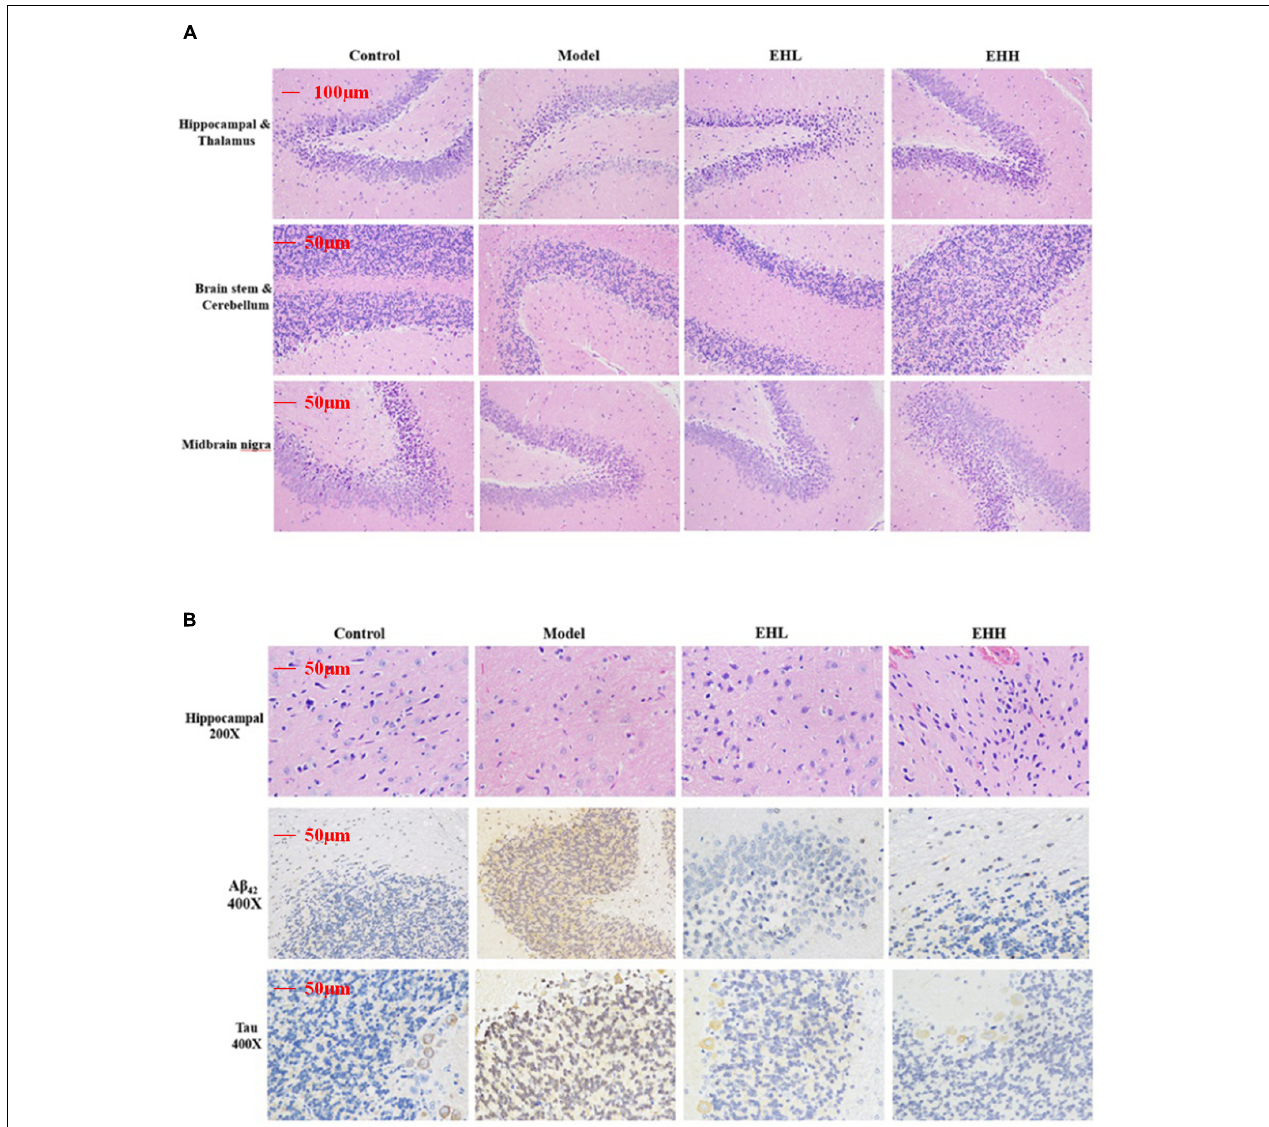
FIGURE 2 | Histopathological changes and immunohistochemistry staining of Tau and A β 42 in the brain tissues of D -galactose- induced deficit rats. (A) is the hematoxylin-eosin (HE) staining of hippocampal and thalamus, brain stem and cerebellum, midbrain nigra; (B) is HE staining of hippocampal, immunohistochemistry staining of the expression of A β 42 and Tau protein in